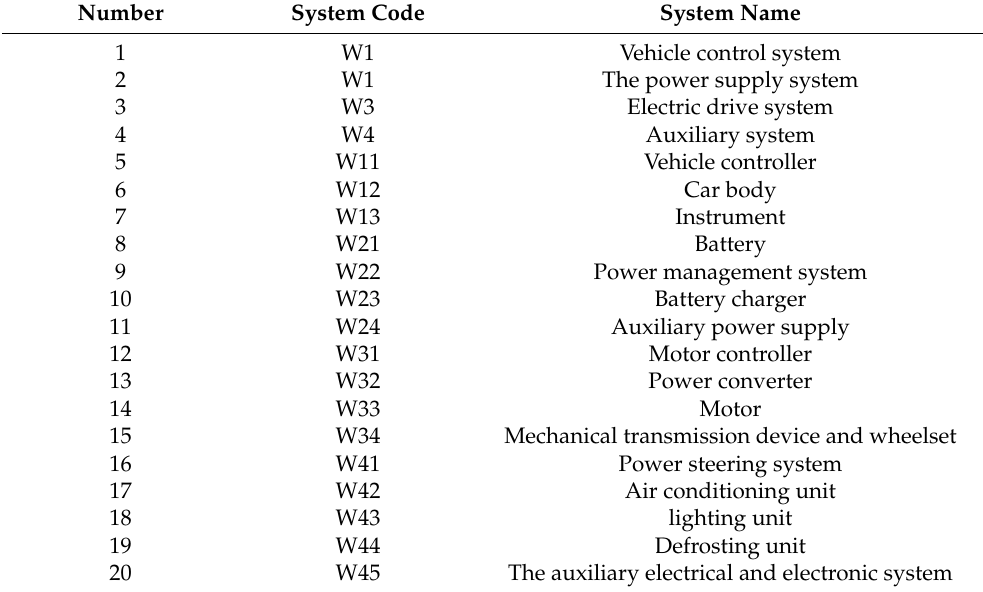
Figure 8. RBS structure tree of the electric vehicle fire.